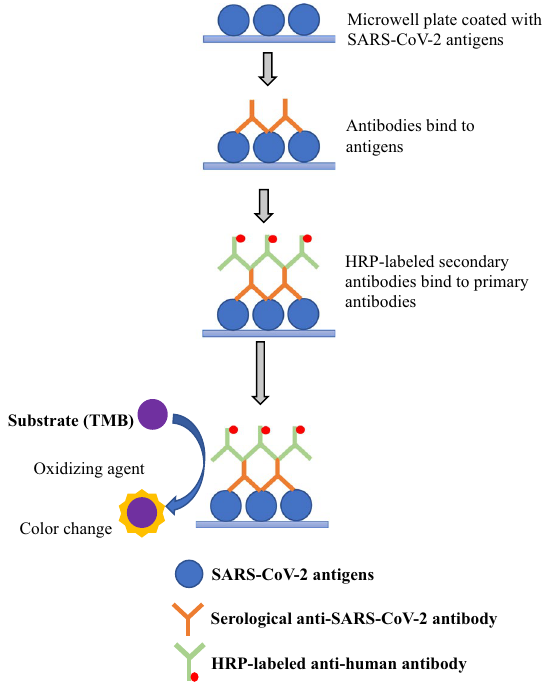
Fig. 3 Schematic illustration of ELISA. Antigens from the sample being tested are attached to a surface. The antigens will bind to the matching antibodies applied onto the surface. Antibodies are attached to an enzyme, and any unbound antibodies are eliminated. The enzyme’s substrate is added in the final stage. If binding occurs, the subsequent reaction generates a visible indication, most typically by a change in colour change. Adapted from Xu et al .